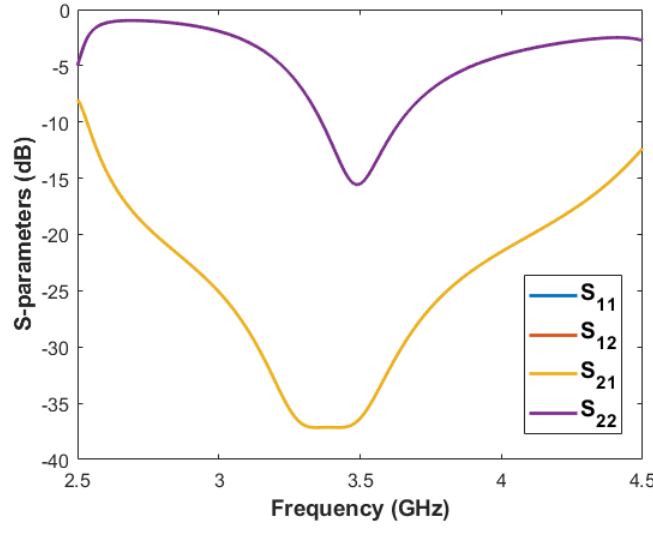
Figure 7. Simulated S-parameters results of the proposed MIMO antenna.